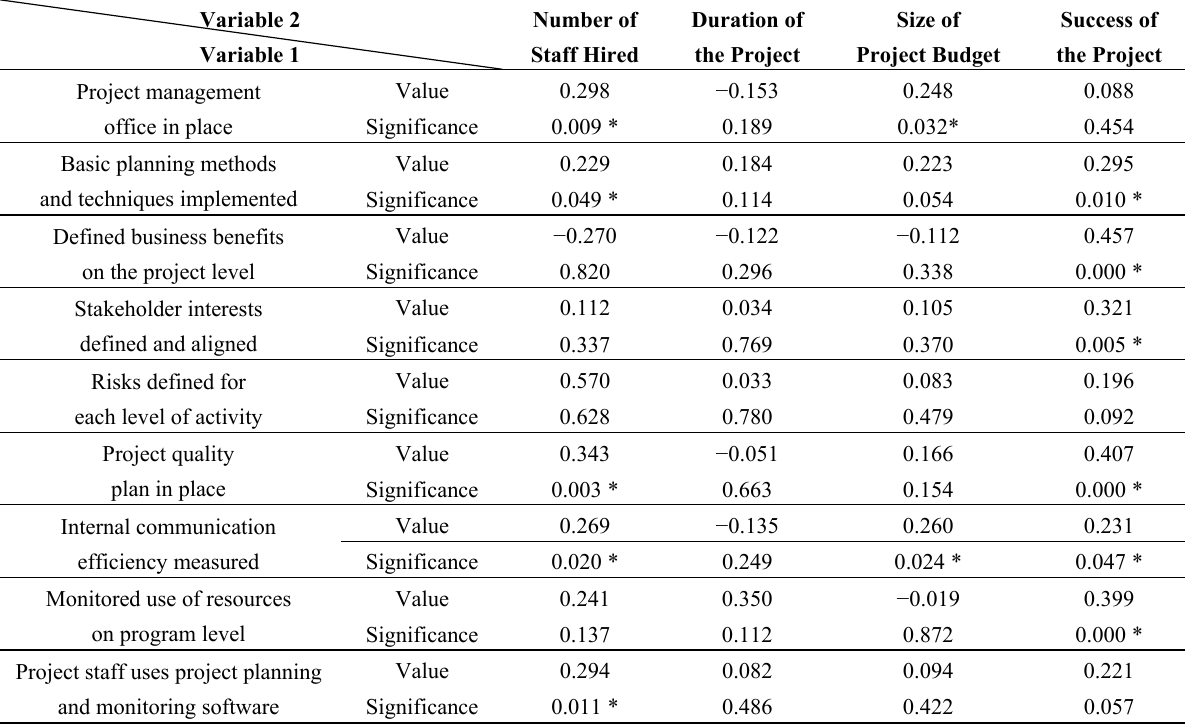
Table 2. Analysis of dependencies between variables using Pearson correlation